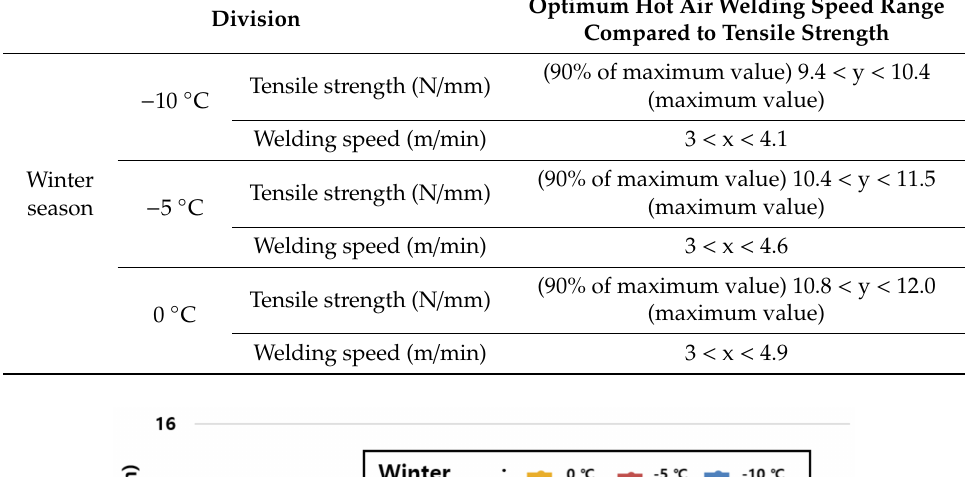
Table 8. Optimum hot air welding speed range compared to joint tensile strength in winter.